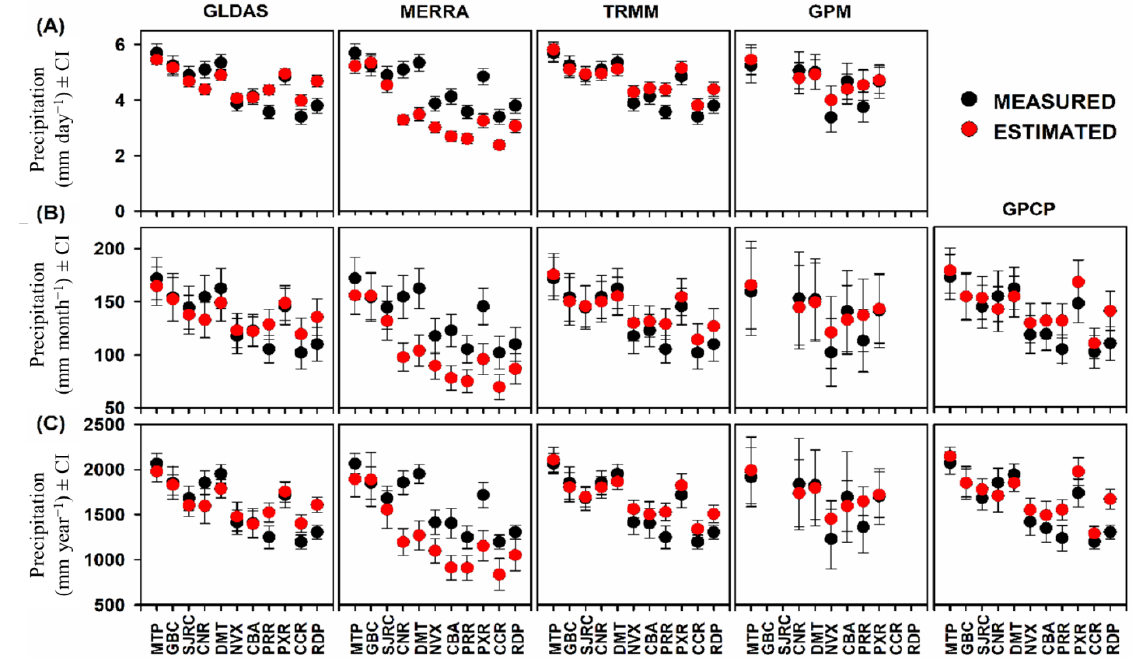
Figure 5. Average values with the corresponding ± Confidence Interval (CI) of ( A ) daily (mm day −1 ), ( B ) monthly (mm month −1 ), and ( C ) annual (mm year −1 ) precipitation as measured by conventional weather stations and estimated by the GLDAS, MERRA, TRMM, GPM, and GPCP products in the state of Mato Grosso, Brazil. For ( A ), the daily values for the entire study period were averaged, while for ( B ), the total monthly values for all months during the study period were averaged, and the annual values in ( C ) were the annual values averaged for all years during the study period.